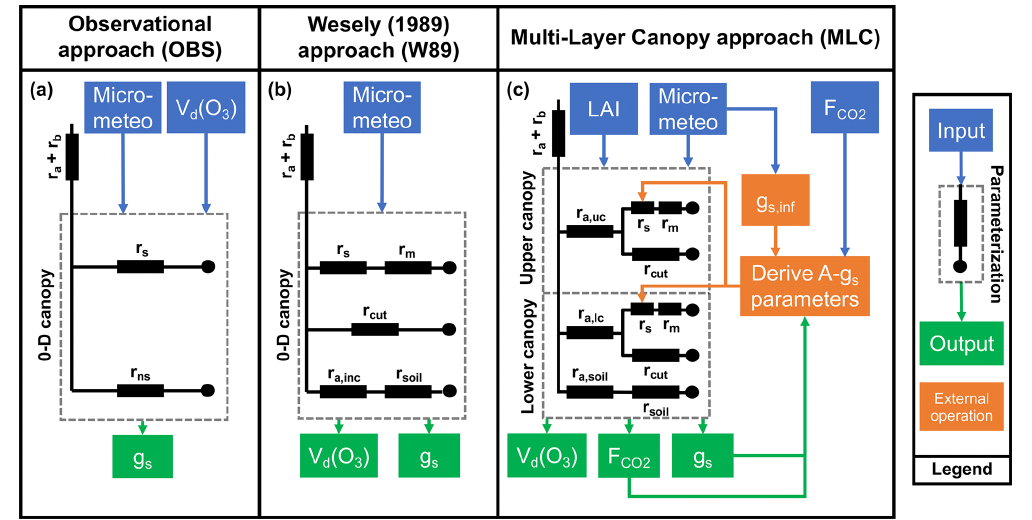
Figure 1. Schematic display representing the biophysical controls on surface ozone removal in plant canopies in the three different ap- proaches in this study, together with their input and output variables. The combination of uptake resistances (shown as black rectangles) inside the dashed gray rectangle yields the bulk canopy resistance ( r c ). In- and output variables of the mechanisms are shown in blue and green, respectively. Orange rectangles in panel (c) display the derivation of photosynthesis parameters required in MLC-CHEM; this proce- dure is described in more detail in Appendix A. The shown resistances are the stomatal resistance ( r s ), bulk canopy non-stomatal resistance ( r ns ), resistance to cuticular uptake ( r cut ), the resistance to in-canopy transport ( r a,inc ), resistance to soil uptake ( r soil ), and resistance to in-canopy transport in the upper canopy layer ( r a,uc ), lower canopy layer ( r a,lc ), and to the soil ( r a,soil